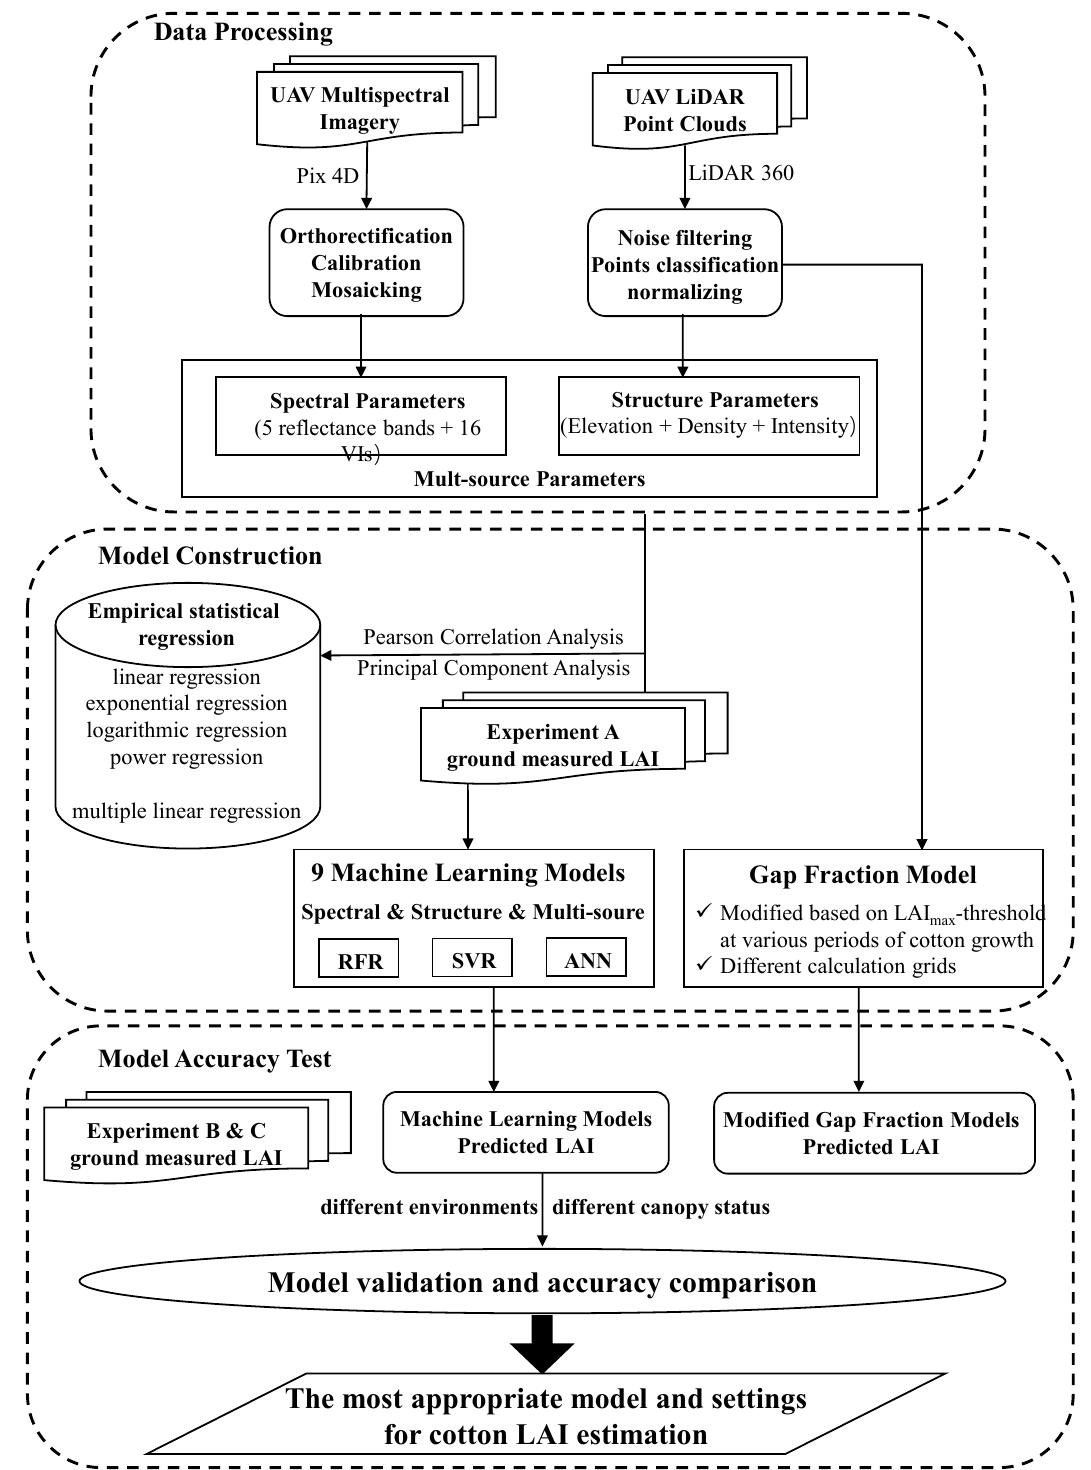
Figure 4. Flowchart of cotton LAI retrieval using multispectral and LiDAR UAV datasets.